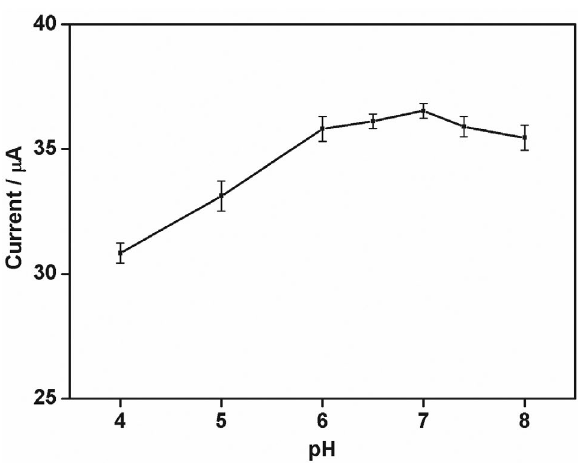
Fig 7. The influence of pH on the oxidation peak current (DPV) of 0.5 mM nitrite at the prepared PEDOT/Fe 3 O 4 -CNCC/GCE.